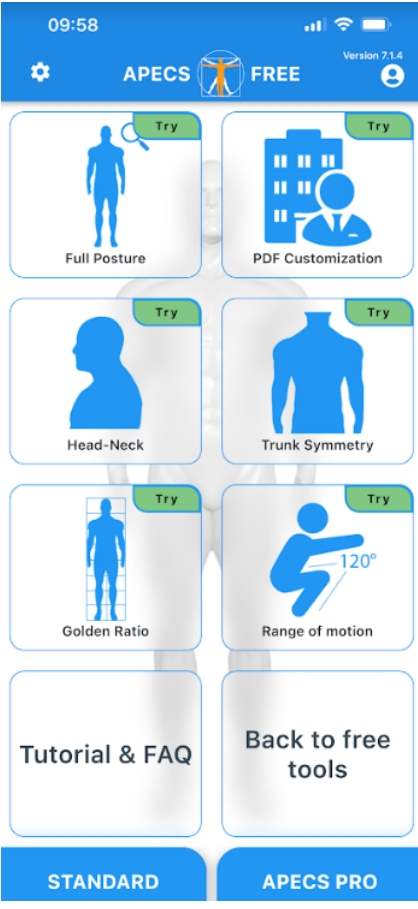
Figure 5. APECS. (This figure is a snapshot taken by the screen of the